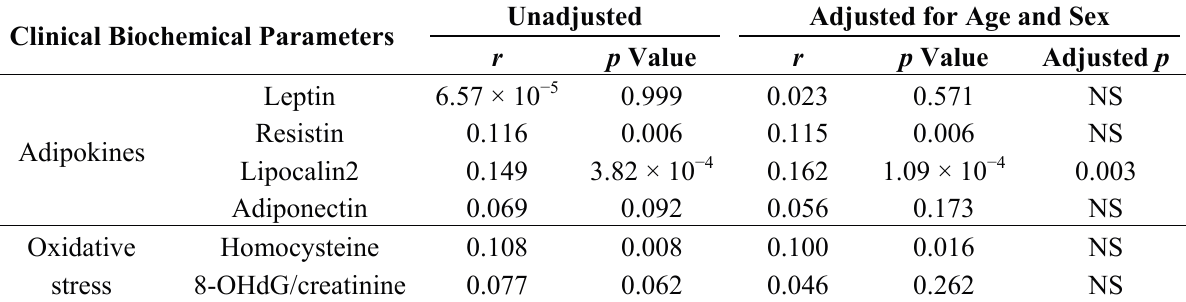
Abbreviations as Table 1. NS: No Significance; 8-OHdG: 8-hydroxy-2-deoxyguanosine. BP levels and lipid variables were analyzed with the exclusion of subjects using antihypertensive drugs and/or lipid-lowering agents. Fasting plasma glucose and insulin and HOMA-IR index were analyzed with the exclusion of anti-diabetic medications. CRP level was calculated with the exclusion of subjects with CRP levels above 10 mg/L.